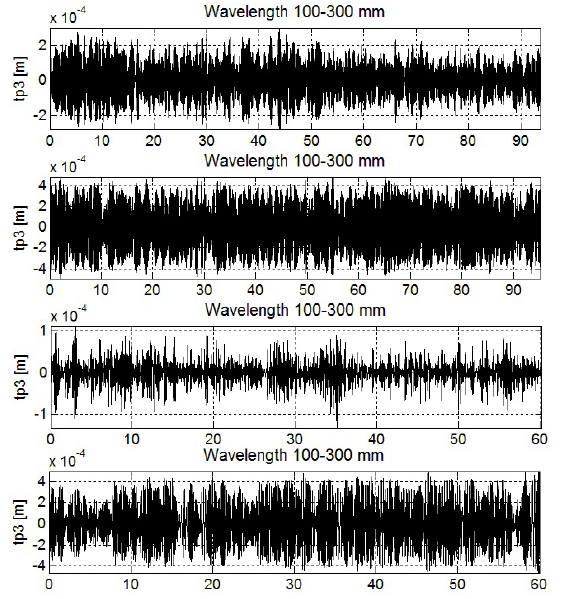
Figure 6. Category of wavelengths 100 Ãů 300 mm Havlickuv Brod (from the top: curve A of the first track, curve A of the second track, curve B of the first track and curve B of the second